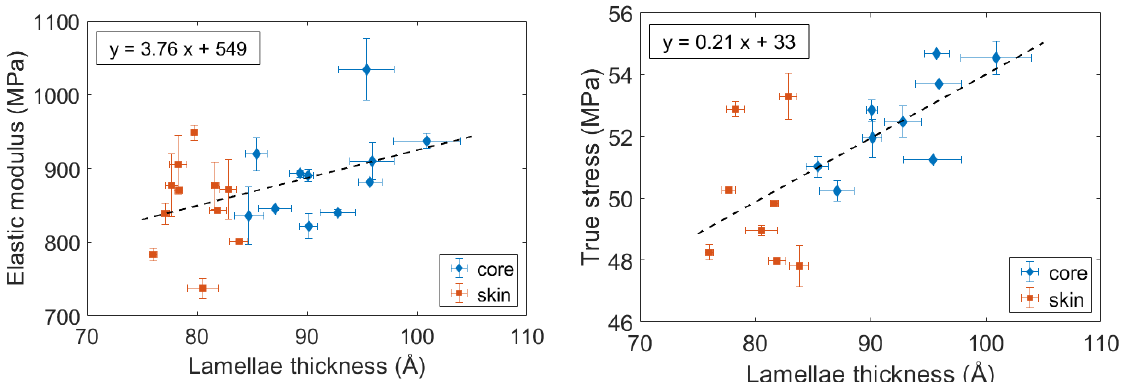
Figure 20. Influence of the lamellae thickness on the PA66 stiffness: Elastic modulus and true stress at a 0.2 strain.